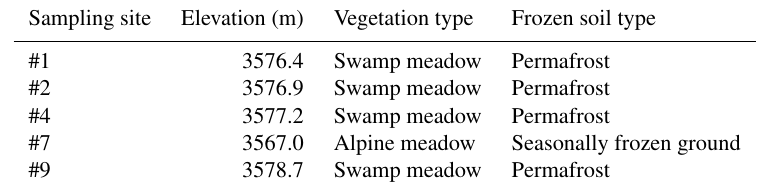
Table 3. Information on the field sampling site for the soil physical parameters from October 2015 to August 2016 at the Mahan Mountain.